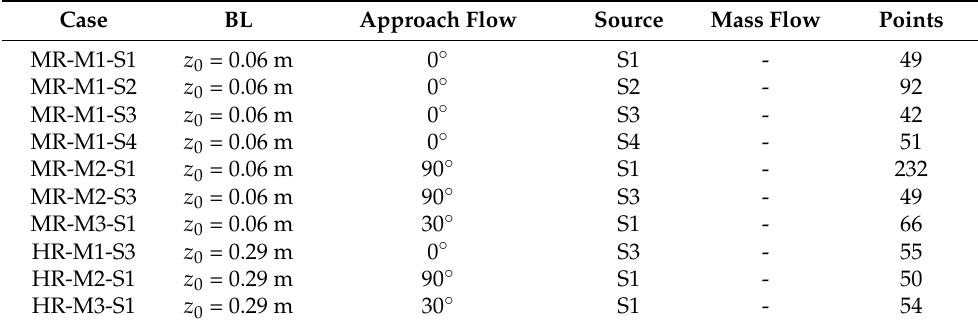
Table 2. Case definition for the neutrally buoyant gas release.